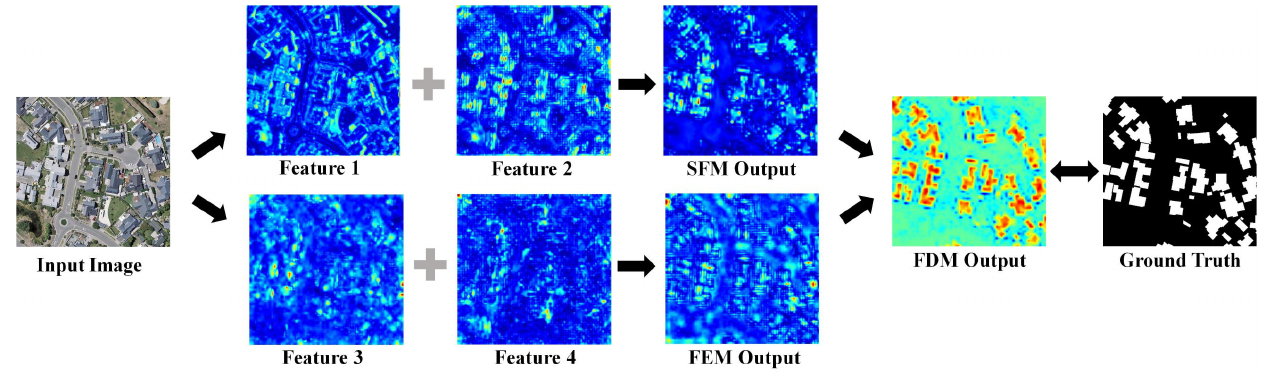
Figure 11. Heatmaps of CFENet’s feature maps. SFM Output represents the feature maps output by the spatial fusion module. FEM Output represents the feature maps output by the focus enhancement module. FDM Output represents the feature maps output by the feature decoder